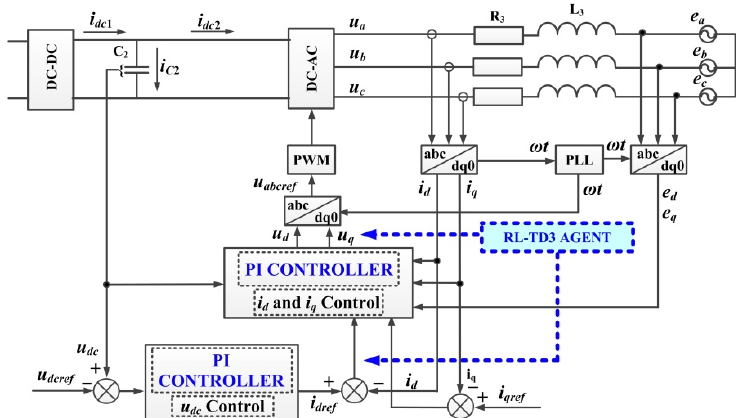
Figure 4. The schematic diagram of the control system for the GC-PV system based on PI-type controllers.